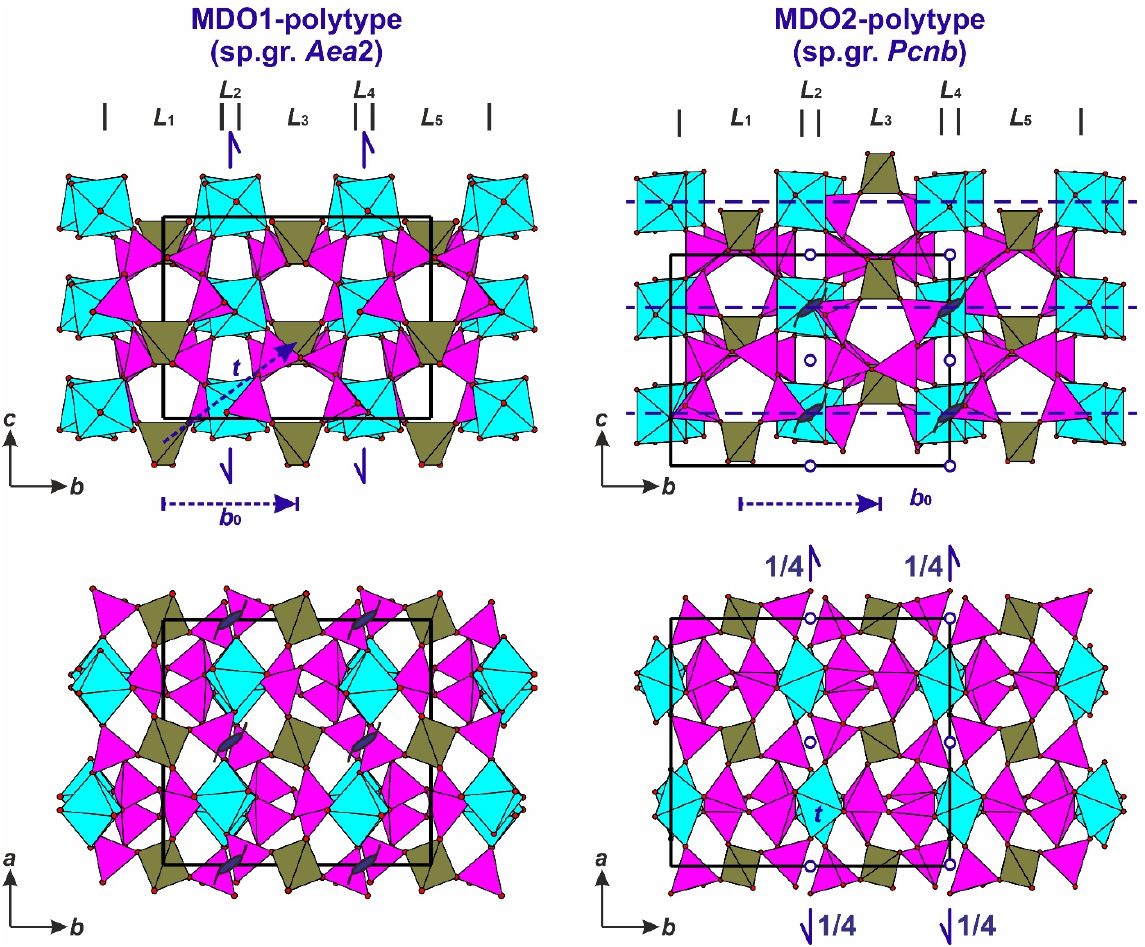
Figure 3. The general views of the MDO1 (with the space group Aea 2) and MDO2 (with the space group Pcnb ) polytypes. The operations active in the L 2 n type layers as well as the generating operations are shown. Legend: AlO 6 -octahedra are colored in cyan; PO 4 -tetrahedra are colored in purple; T O 4 -tetrahedra are colored in dark yellow. Extra-frameworks Cs atoms are omitted.